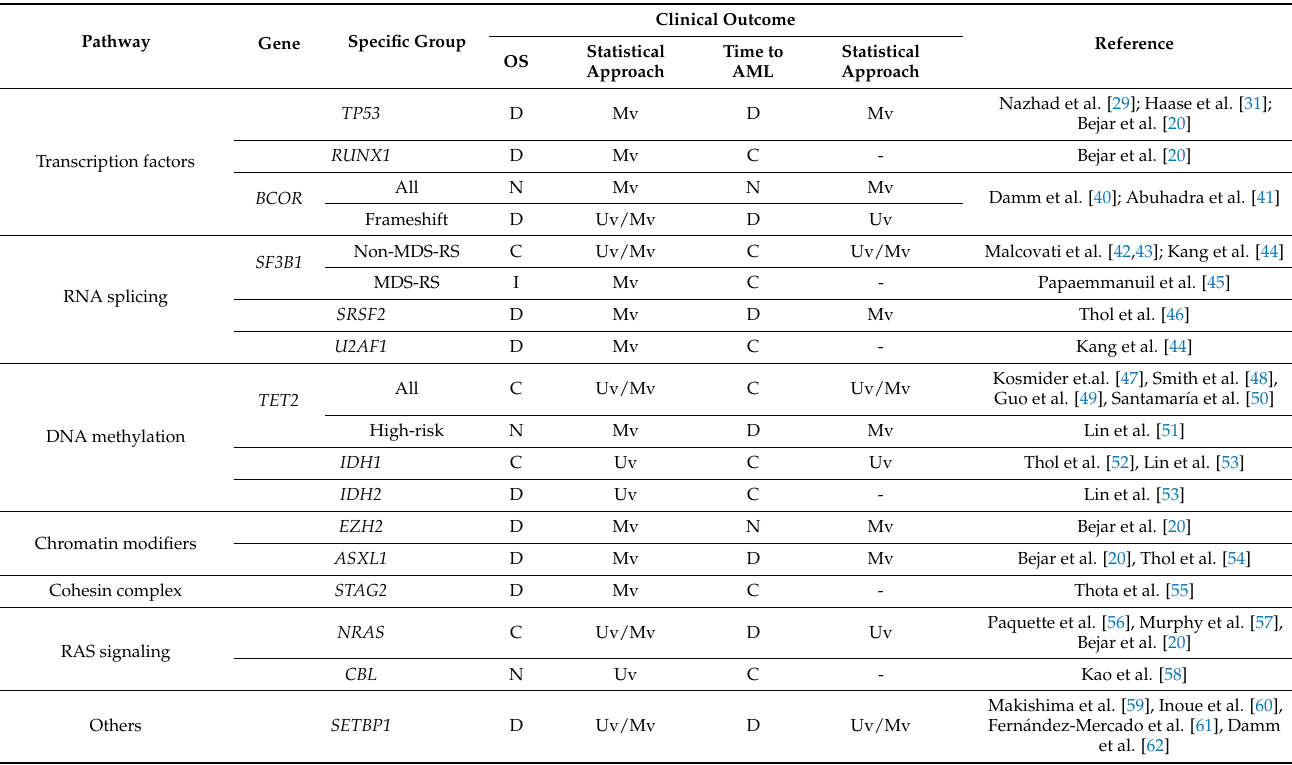
Table 5. Somatic mutations and their association with clinical prognostic impact on outcome of myelodysplastic syndrome. Clinical Pathway Gene Specific Group